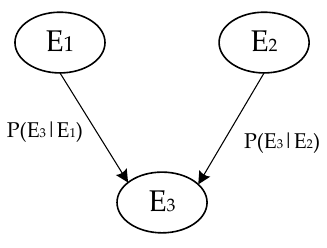
Figure 4. Bayesian network.